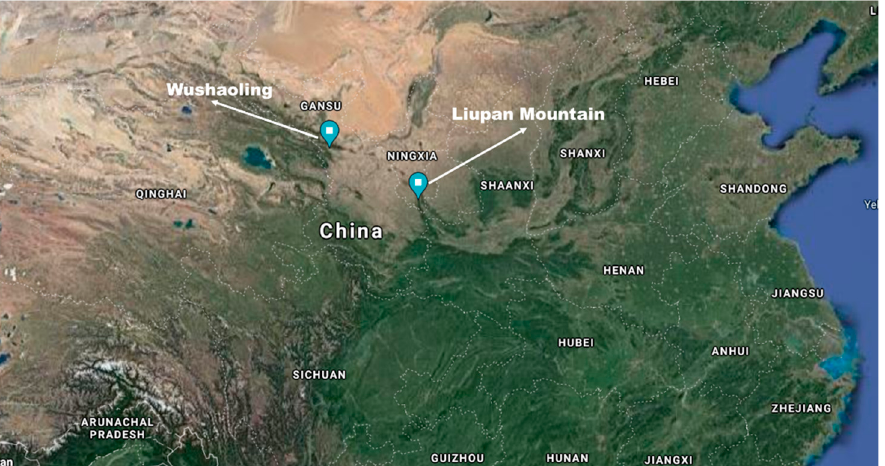
Figure 1. Overview map of the general region. Wushaoling is located in the middle of Tianzhu Tibetan Autonomous County, Wuwei City, Gansu Province, southeast end of the northern branch of Qilian Mountains. Topographically, Wushaoling is located at the intersection of the Loess Plateau, the Qinghai ‐ Tibet Plateau, and the Inner Mongolia Plateau, with a length of 17 km and an average elevation of 3562 m. Climatically, sub ‐ arid, mid ‐ temperate sub ‐ arid, and mid ‐ temperate arid zone intersect in Wushaoling. The east of Wushaoling is the monsoon region with outflow, and the west is the non ‐ monsoon region with inflow. The main source of surface runoff replenishment are precipitation and melting ice and snow, with a great interannual variation. There is an updraft at the site. Abundant moisture input